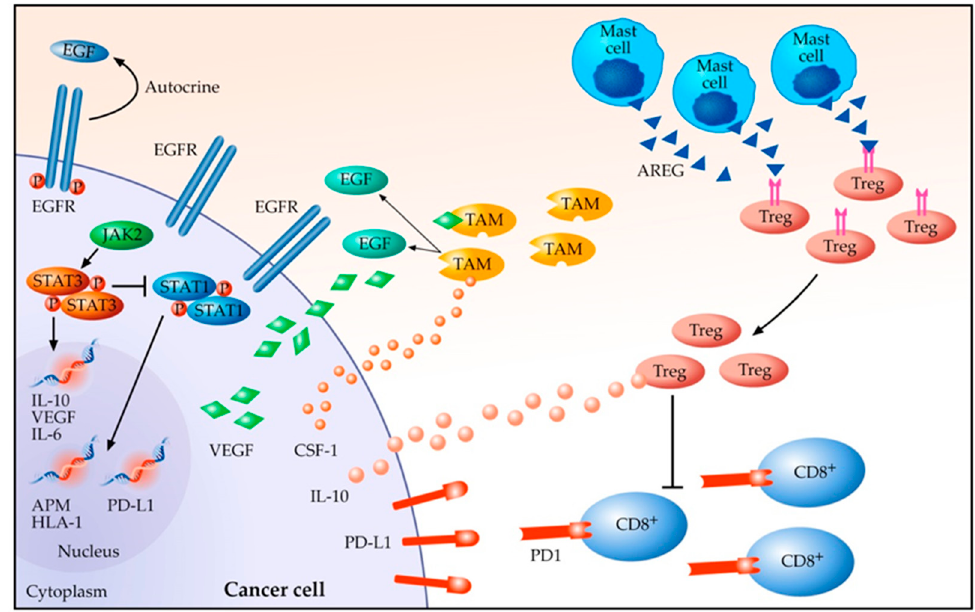
Figure 1. Tumour Microenvironment in EGFR mutated NSCLC. EGF, Epidermal Growth Factor; EGFR, Epidermal Growth Factor Receptor; STAT1 / 3, Signal Transducer and Activator of the Transcription1 / 3; JAK2, Janus Activated Kinase 2; IL, Interleukin, VEGF, Vascular Endothelial Growth Factor; APM, Antigen Presenting Machine; HLA-1, Human Leukocyte Antigen-1; PD-L1, Programmed cell Death Ligand 1; PD1, Programmed cell Death 1; CSF-1, Colony Stimulating Factor-1; TAM, Tumour